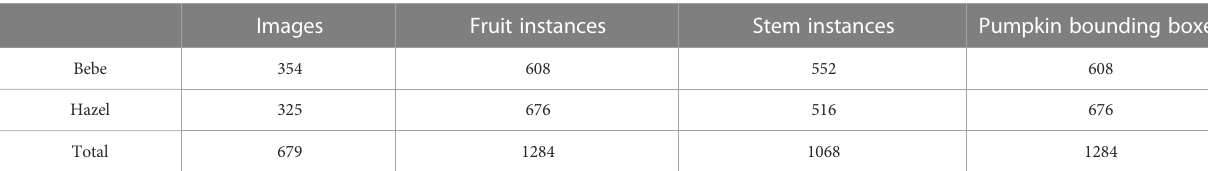
TABLE 1 Distribution of the dataset.